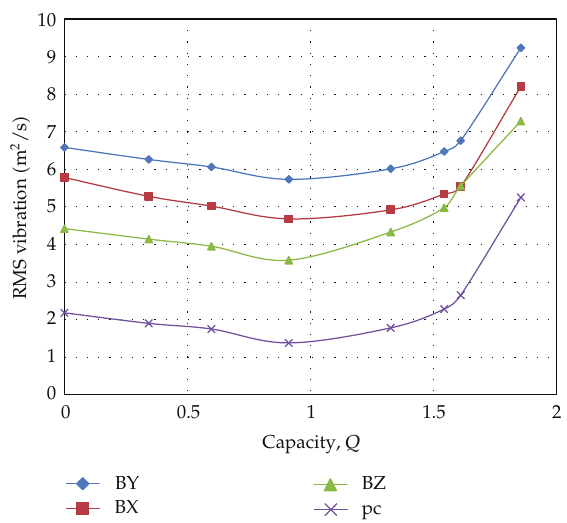
Figure 2: Vibration level in a well-designed centrifugal pump by